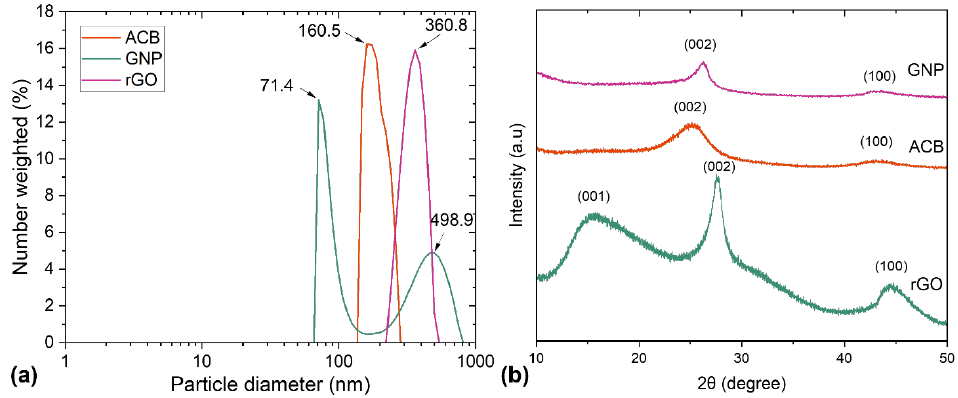
Figure 2. Characterization results of used fillers ACB, GNP, and rGO by ( a ) particle size analyzer, and ( b ) XRD patterns.